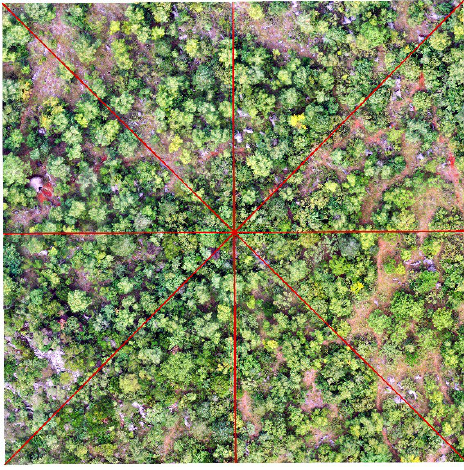
Figure A2. Schematic diagram of canopy depression extraction by sample lines.